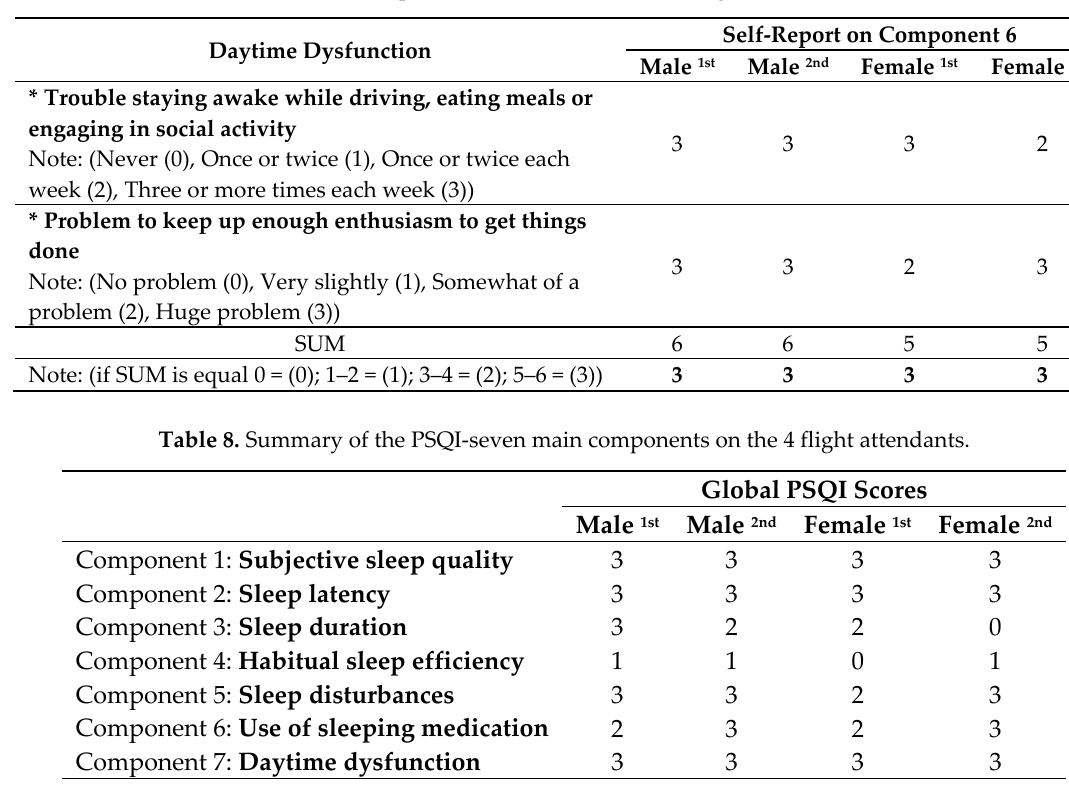
Table 7. Component 7 of the PSQI on the 4 flight attendants.